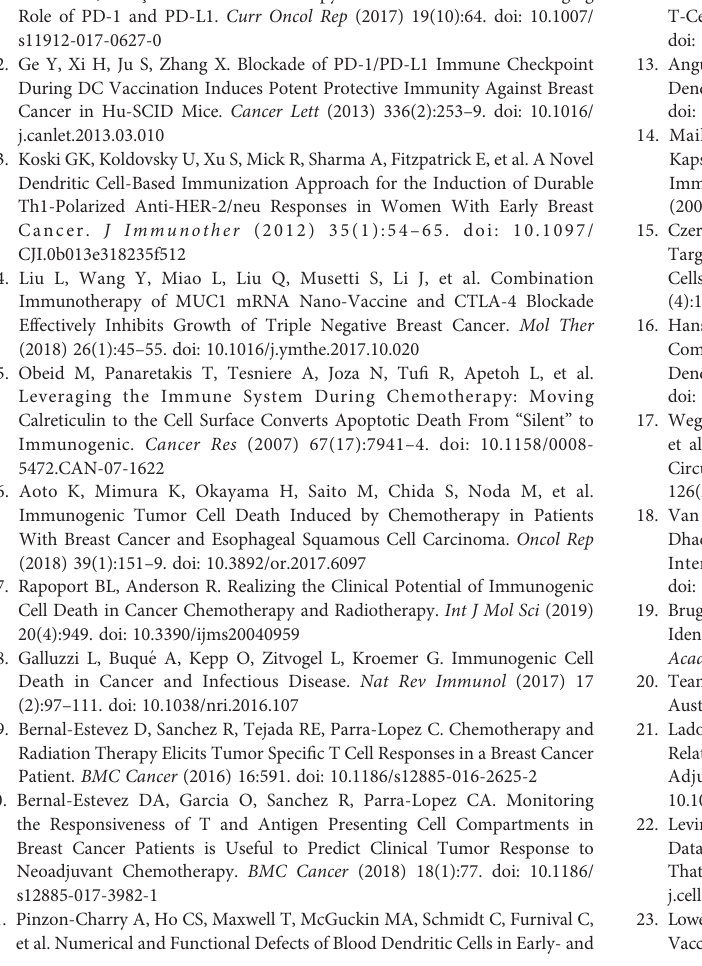
analysis implemented in R software, FCS fi les were exported from live singlet cells in FlowJoandthenexecutedusingCITRUScommand.Dataobtainedwasanalyzedin Prism (v9) for statistical con fi rmation. Supplementary Figure 2 | Validation of FlowSOM and CITRUS in a control group. (A) Analysis of PBMCs obtained from HD (n=10), stimulated ornot during 24 h with beads coupled with anti-CD3, CD28 and CD2. PBMCs were labeled with antibodies against CD3, CD25, CD69 and CD154. tSNE and density plots of concatenated samples overlaying one stimulated sample (Red) and one unstimulated sample (blue). (B) FlowSOM results from 10 HD samples to determine tSNE map and eight sub-populations. (C) Spanning tree of the eight sub- populations de fi ned by FlowSOM showing the expression level of each marker (pie chart). (D) Heat map and hierarchical distribution of the populations determined by FlowSOM, and (E) distribution of each population in control or stimulated cells (blue and red bars respectively). (F) CITRUS analysis of the populations represented in the spanning tree. (G) Expression levels of each marker (red histogram) compared to background (blue histogram) in each cluster whose expression exhibited statistical difference between both groups (unstimulated vs. stimulated cells). (H) The model curve of CITRUS for false Discovery rate (blue line) and cross- validation error rate (red line). (I) The relative abundance of three clustered cells that exhibited statistically different patterns of CD3 internalization in cells of 10 HD unstimulated or stimulated with beads in-vitro is presented as control and stimulated